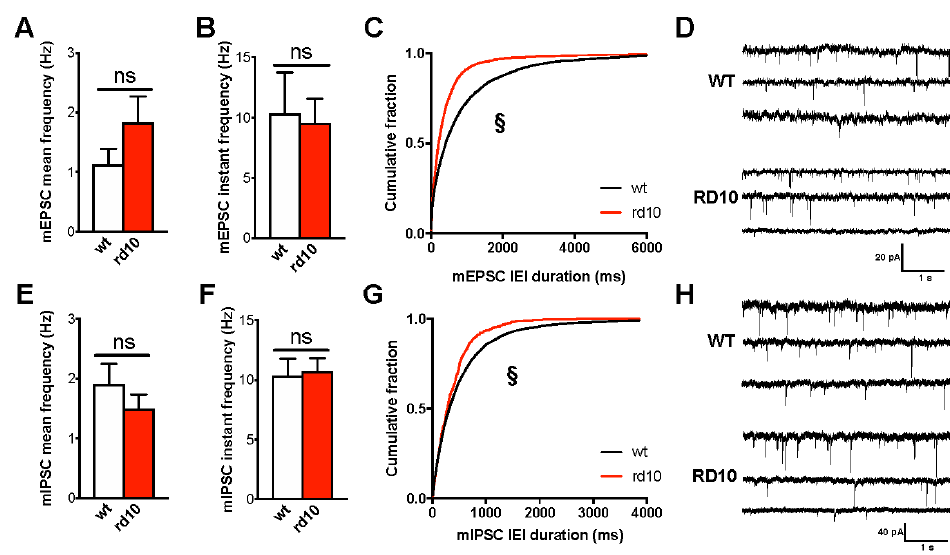
Figure 3. Basal synaptic function in the visual cortex of rd10 mice at P60. ( A , B ) Average mEPSC frequency in pyramidal cells of layer II/III of wt ( n = 11 cells, 6 mice) and rd10 animals ( n = 10 cells, 7 mice). No difference was found in mean ( t -test, p = 0.174) and instant frequency (Mann–Whitney rank sum test, p = 0.504). ( C ) Cumulative distribution of mEPCS interevent intervals highlighted a significant reduction (Kolmogorov–Smirnov test, p < 0.001). ( E , F ) Average mIPSC fre- quency in pyramidal cells of layer II/III of wt ( n = 12 cells, 6 mice) and rd10 animals ( n = 13 cells, 6 mice). No difference was found in mean ( t -test, p = 0.323) and instant frequency ( t -test, p = 0.834). ( G ) Cumulative distribution of mIPCS interevent intervals showed a small but significant reduction (Kolmogorov–Smirnov test, p < 0.001). ( D – H ) Representative traces recorded from wt and rd10 neurons voltage clamped at − 85 mV for mEPSCs and at − 75 mV for mIPSCs. For each group, the middle trace represents the mean frequency, while the top and bottom ones are mean plus and minus SD, respectively. Data are expressed as mean ± s.e.m. § p < 0.001, and ns: not significant.